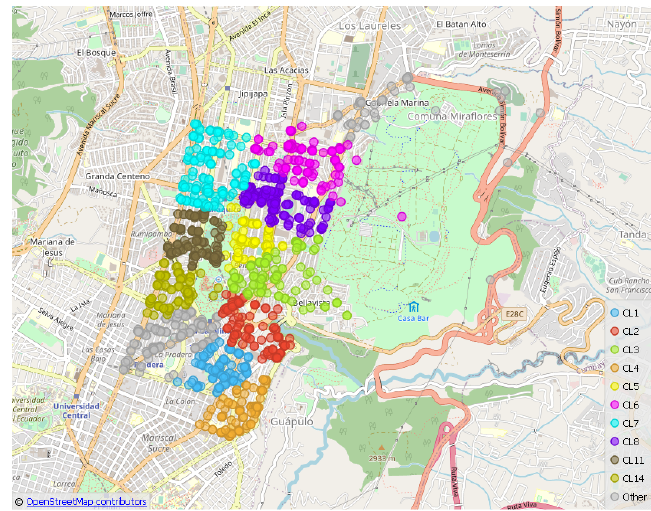
Figure 9. Application of k-means to C 10 circuit with k Clusters.